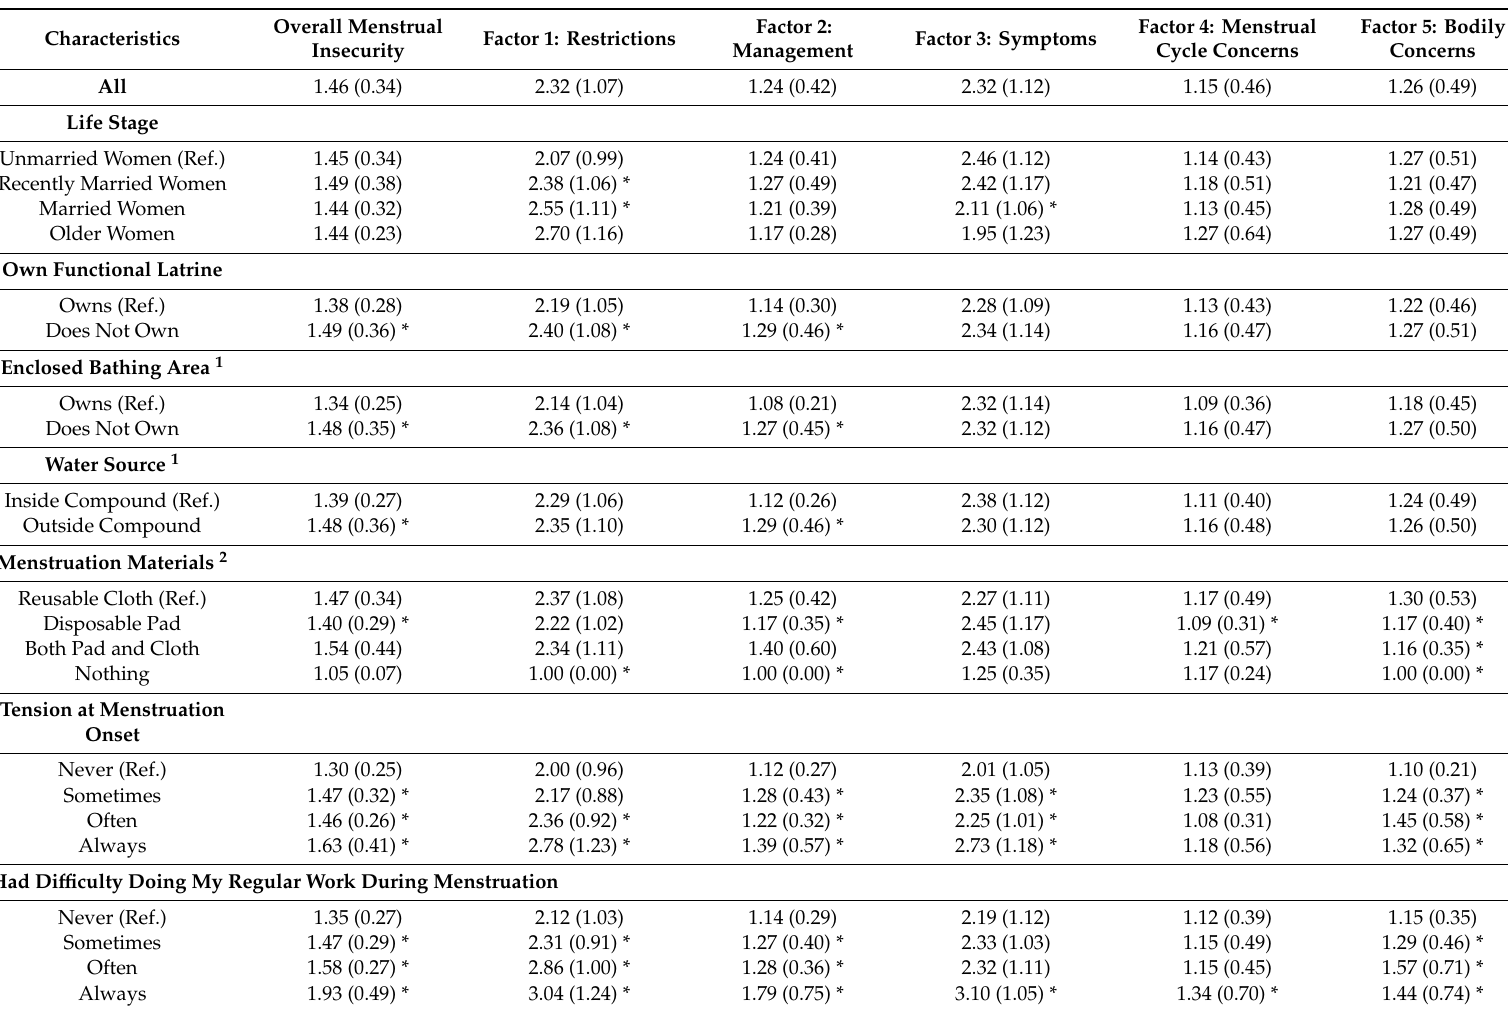
Table 5. Overall Menstrual Insecurity and individual sub-scale scores by life stage-, WASH-, and health-related items (N = 878).